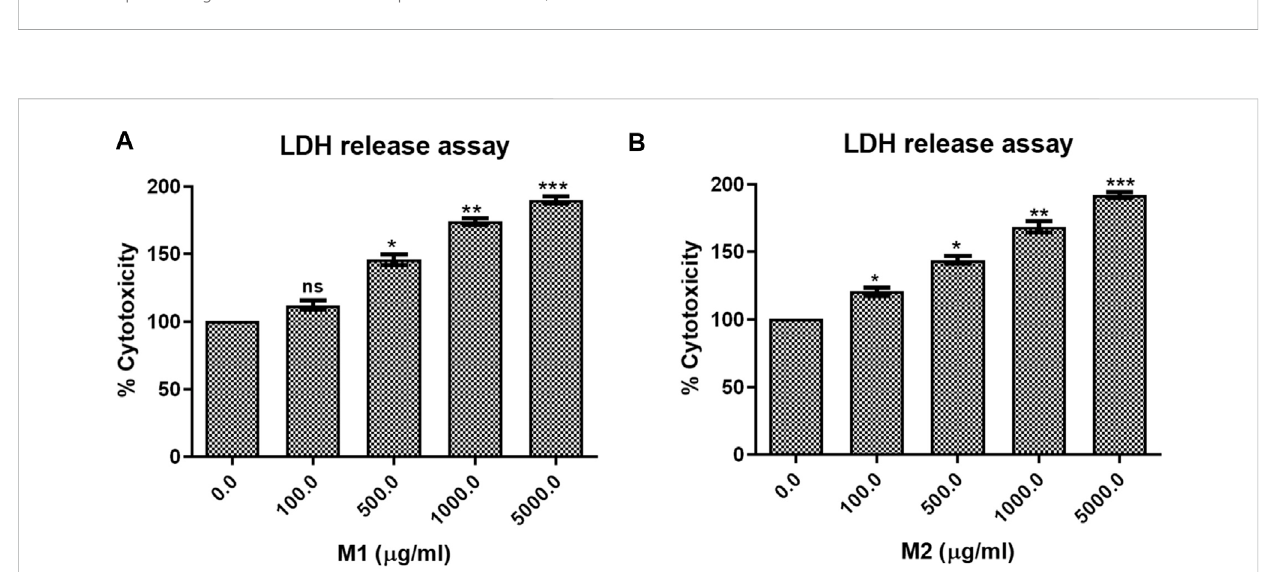
FIGURE 5 LDH release assay. Percent cytotoxicity in HCT-116 cells treated with different doses of (A) M1 and (B) M2 (100 – 5,000 μ g/mL) for 24 h. The results shown are the mean ± SEM of three independent experiments performed in triplicate (ns > 0.01, * p < 0.01, ** p < 0.001, and *** p < 0.0001 represent signi fi cant differences compared to control).